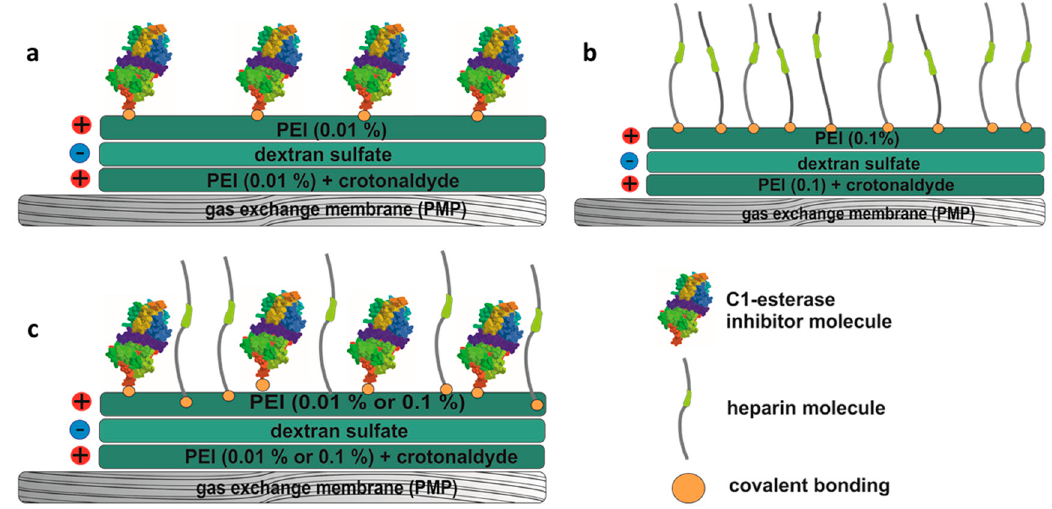
Figure 2. Schematic representation of the generated coatings. ( a ) C1-INH coating, ( b ) heparin coating, ( c ) the combined coating of C1-INH and heparin.